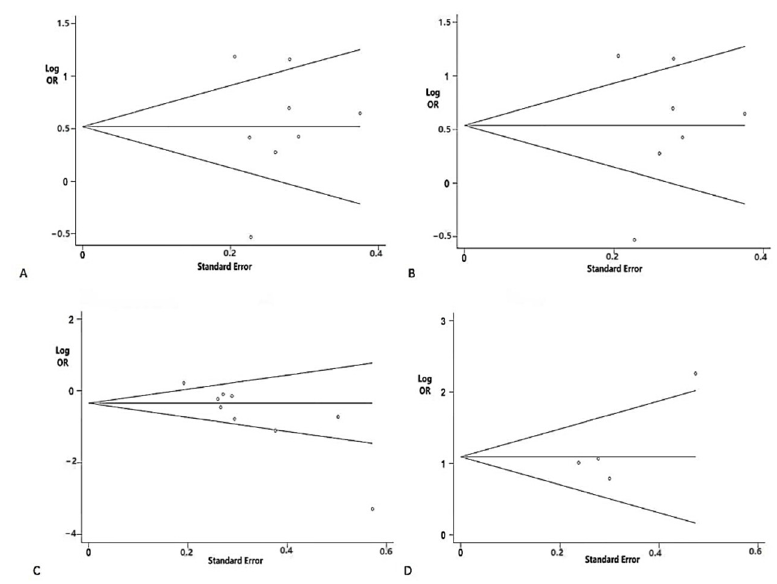
Figure 5. Funnel plot analysis used to detect publication bias: ( A ) cVEMP P13 latencies ( p = 0.805 by Begg’s test); ( B ) oVEMP P15 latencies ( p = 0.881 by Begg’s test); ( C ) peak-to-peak amplitude of cVEMP ( p = 0.004 by Begg’s test); ( D ) AAR of mVEMP ( p = 0.497 by Begg’s test).